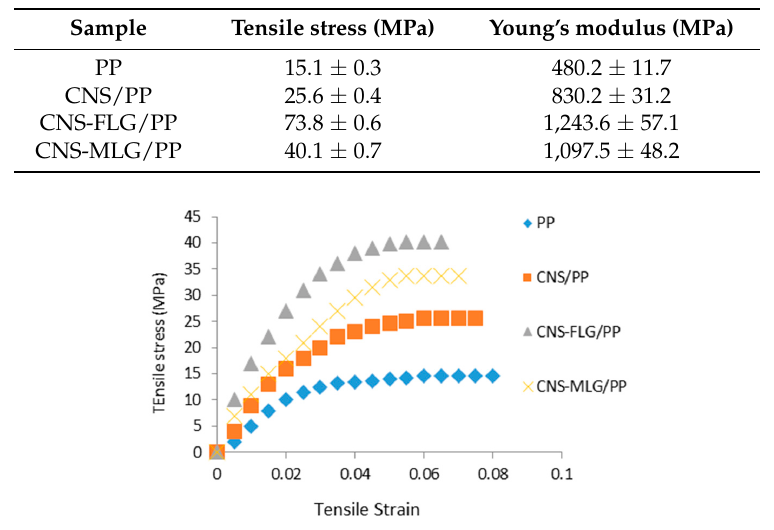
Figure 9. Tensile stress–strain graph of PP, CNS/PP, CNS-FLG/PP and CNS-MLG/PP.